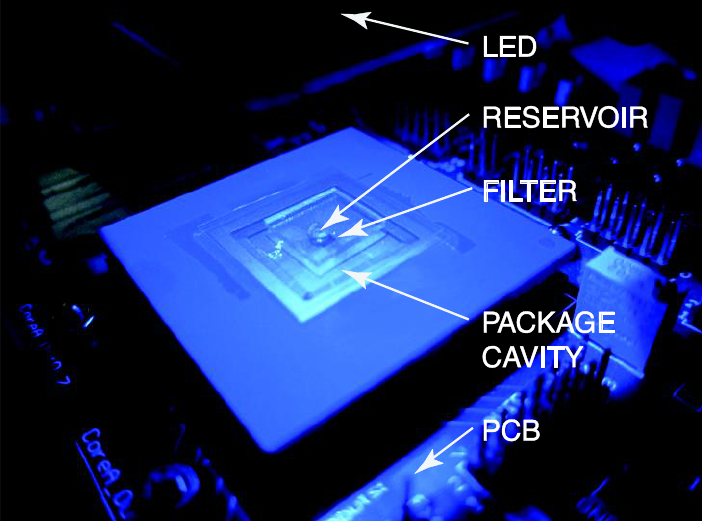
Figure 4. CMOS fluorescent contact imaging microsystem